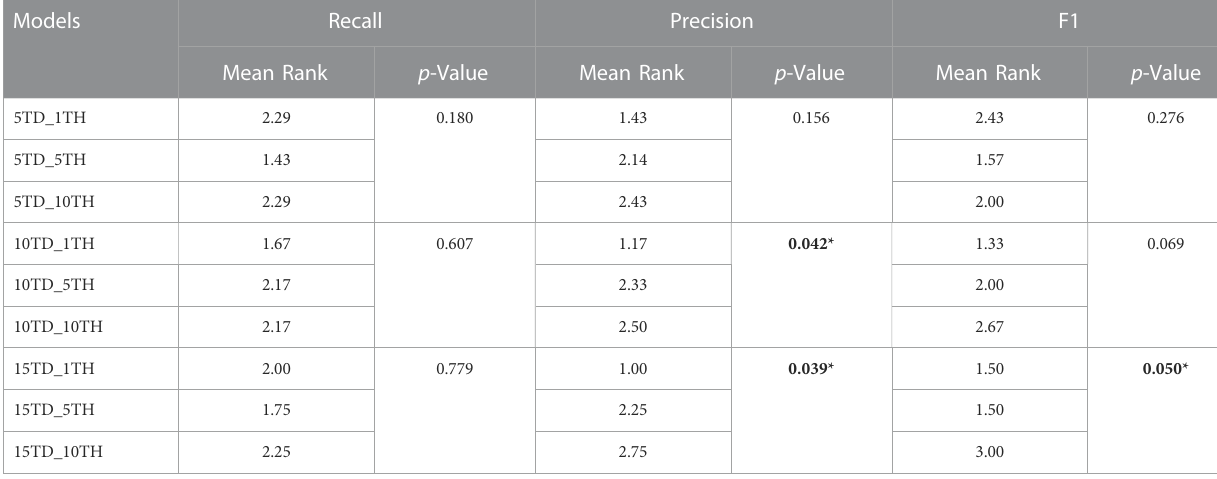
TABLE 4 Performance evaluations of different models using Friedman ’ s test.